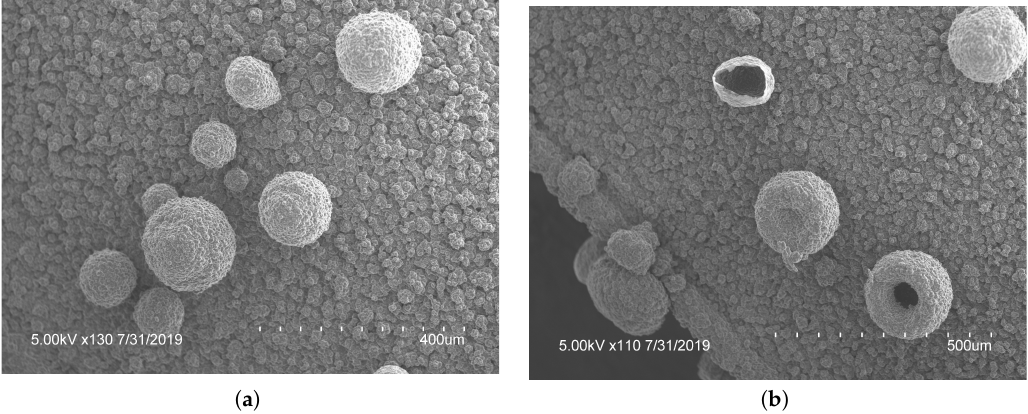
Figure 3. Scanning electron microscopy images of different polypyrrole (PPy) microstructures; ( a ) closed and ( b ) open structures were produced by applying 3 cycles of 0–1.4 V, 1 cycle of − 0.8– ( − 1.2 ) V to create bubbles, followed by 4 cycles of PPy polymerization 0–1.4 V. Showing the variance of structures capable on a single